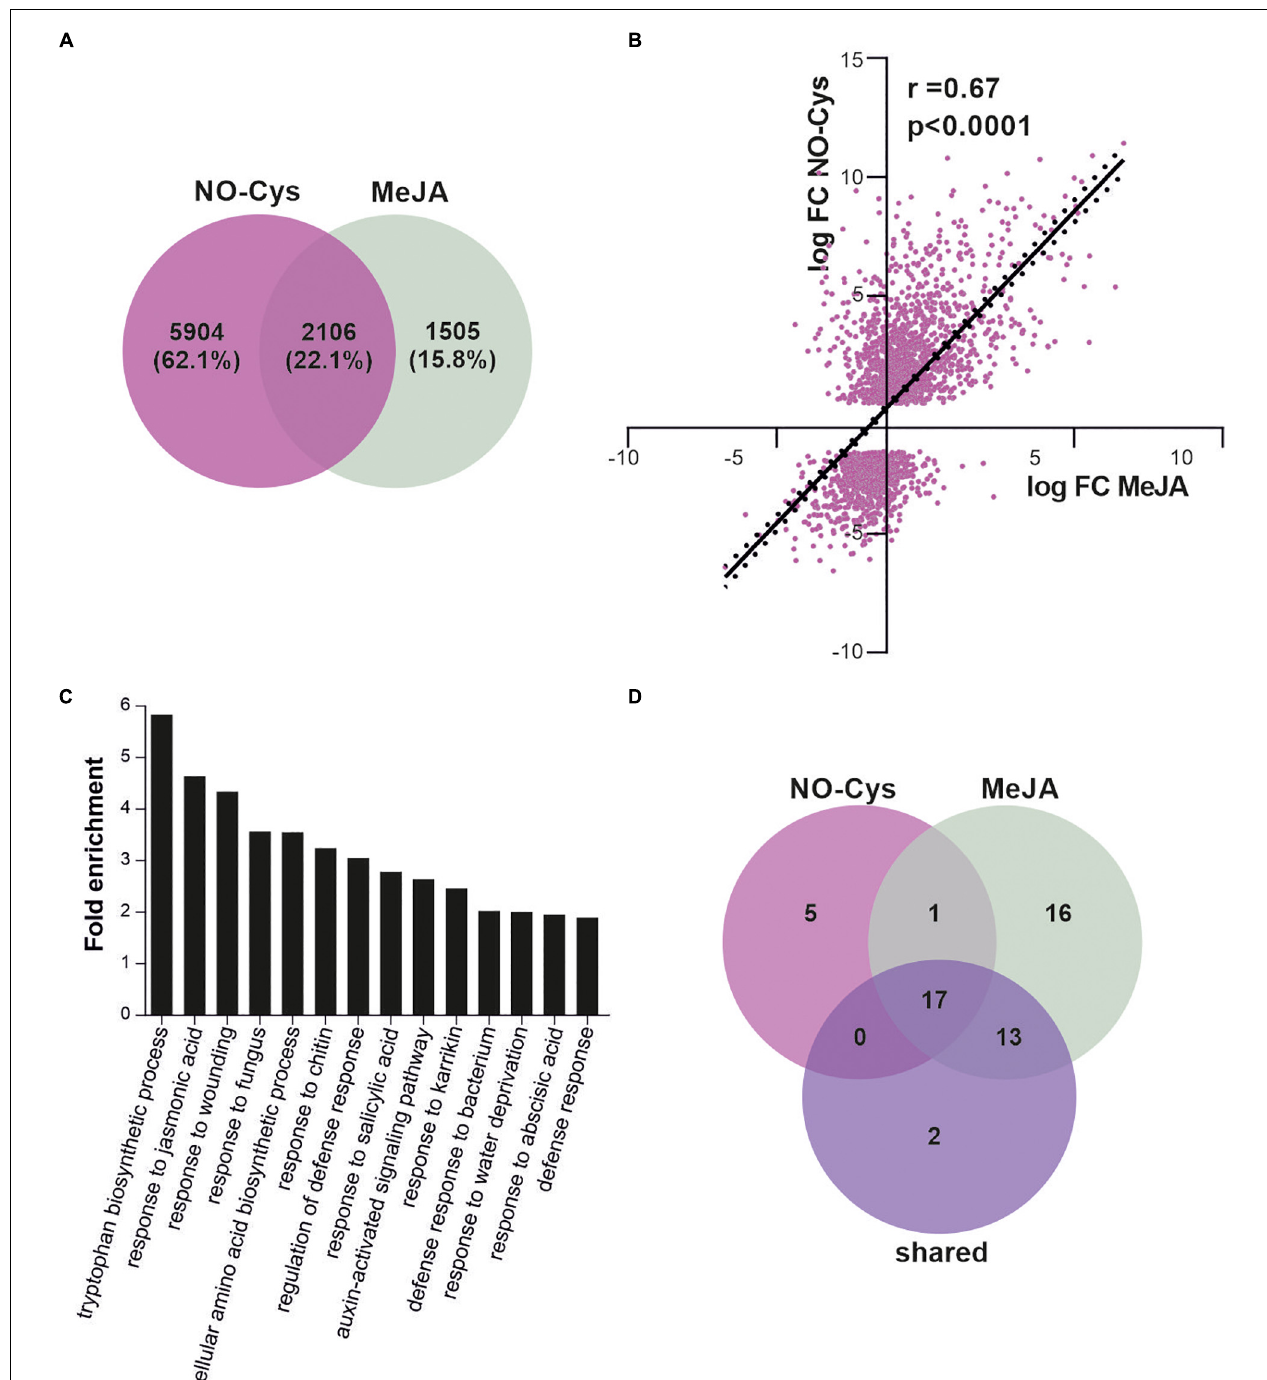
FIGURE 5 | NO regulation of SCF COI1 -mediated JA response gene expression. (A) Differentially expressed genes (DEGs) upon 6 h of NO-Cys treatment (purple) or 6 h of MeJA treatment (grey) in 3 weeks-old A. thaliana plants compared to control conditions. Raw data from Hussain et al. (2016) were downloaded and analyzed as described in section “Materials and Methods.” Only genes with absolute logFC > 1 and p -value < 0.0001 were selected as DEG. DEGs upon MeJA were selected from Hickman et al. (2017). (B) Correlation of change in expression levels for shared genes in (A) (2106 genes in total). Values are logFC after 6 h of treatment with NO-Cys or MeJA. Black line represents the linear regression line ( Y = 1.112 ∗ X + 0.7580); r and p -value are indicated. (C) Gene Ontology (GO) term enrichment analysis of DEG upon MeJA and NO-Cys treatment. (D) Venn diagram displaying the number of overlapping GO terms highly enriched for NO-Cys, MeJA, and shared